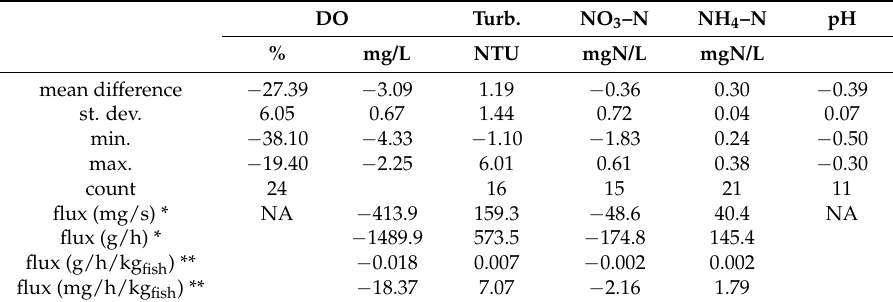
Table 3. Summary of the overall farm differential data between outlets and inlet. Turbidity (Turb.); nitrate (NO 3 –N); ammonium (NH 4 –N); not applicable (NA). DO